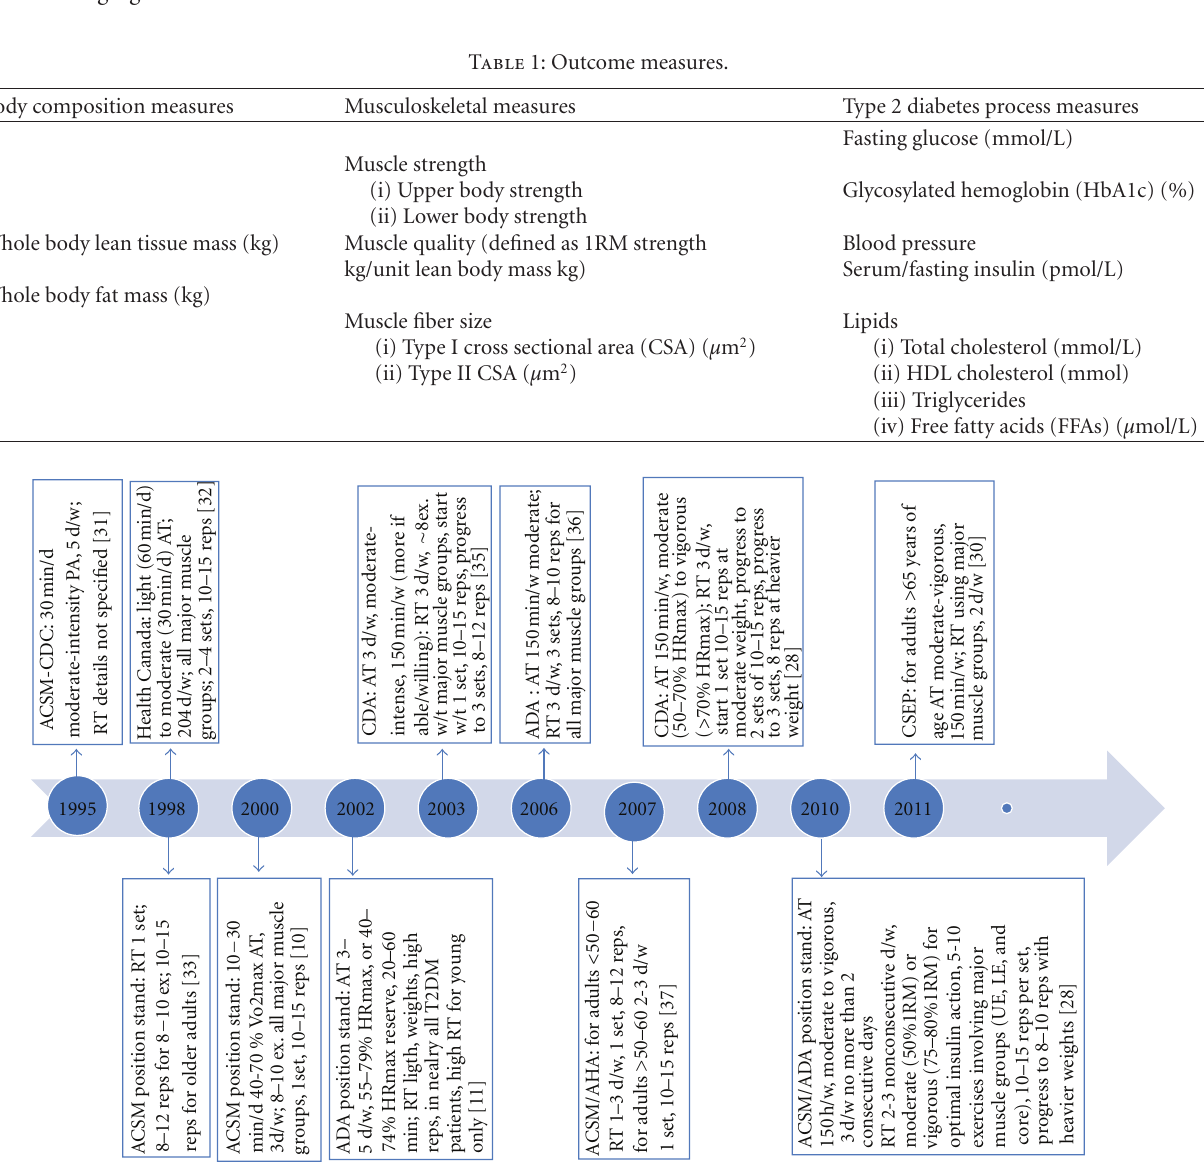
Figure 1: Chronological Timeline of PA Recommendations for T2DM from Various Professional Organizations [modified from [26]]. PHAC [Public Health Agency of Canada]; CSEP [Canadian Society for Exercise Physiology]; CDA [Canadian Diabetes Association]; ACSM [American College of Sports Medicine]; ADA [American Diabetes Association]; CDC [Centers for Disease Control and Prevention]; AHA [American Heart Association]. PA [Physical Activity]; RT [resistance training]; AT [aerobic training]; UE [upper extremity]; LE